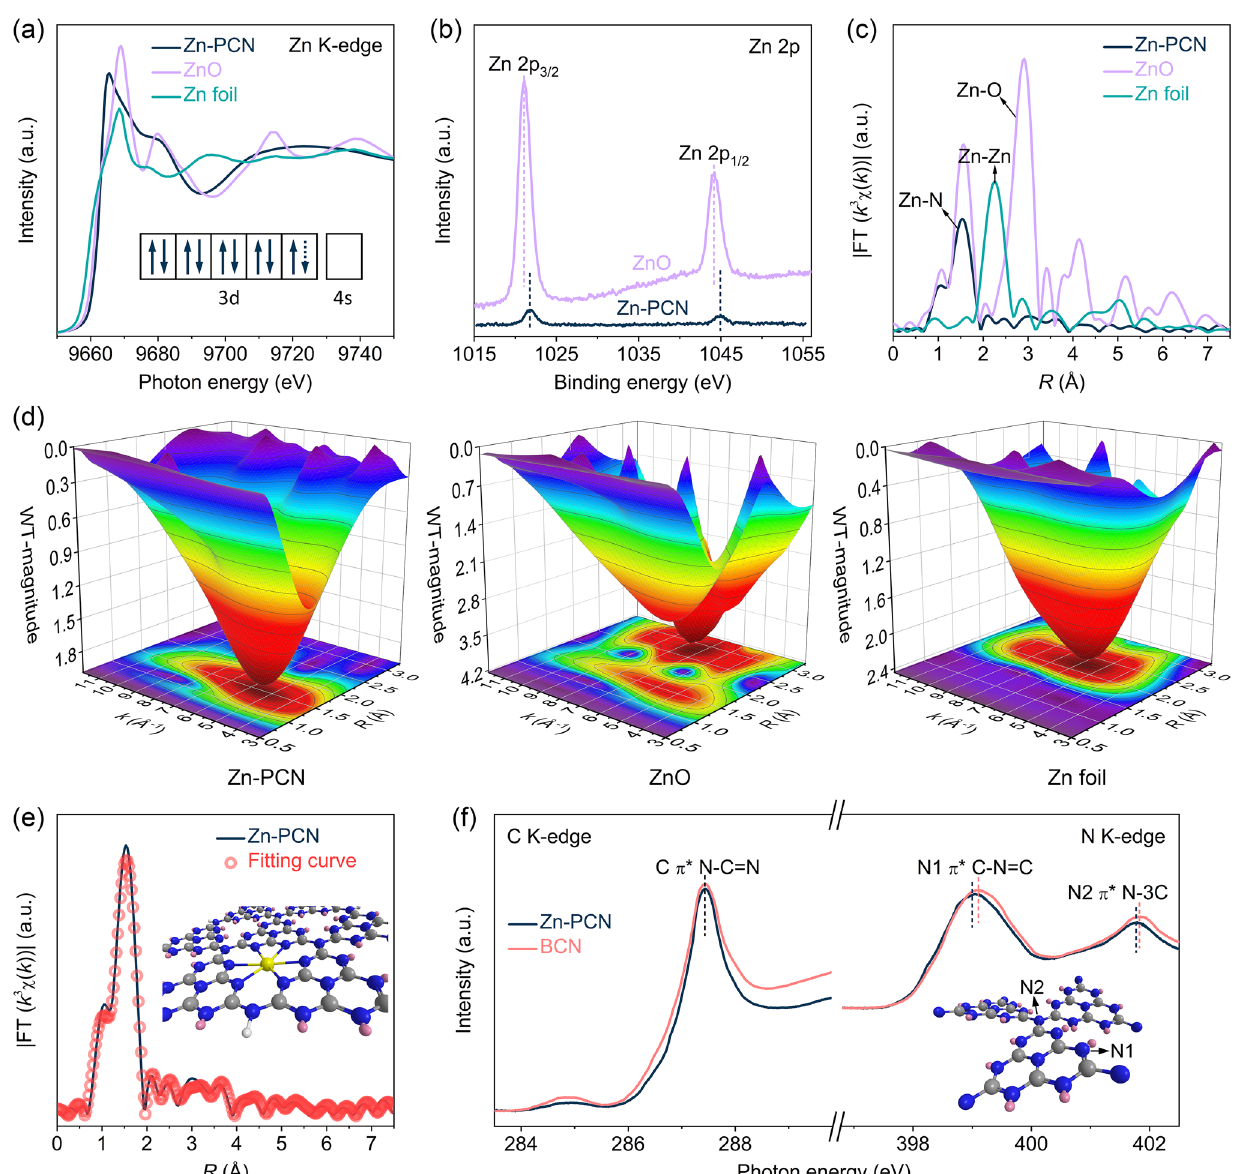
Fig. 2 a Zn K‑edge XANES spectra of Zn‑PCN, ZnO and Zn foil. The inset in a shows the outer electron configuration of Zn single atom in Zn‑PCN. b High‑resolution Zn 2 p XPS spectra of Zn‑PCN and ZnO. c Zn K‑edge k 3 ‑weighted FT‑EXAFS spectra of Zn‑PCN, ZnO and Zn foil. d WT‑EXAFS spectra of Zn‑PCN, ZnO and Zn foil. e Fitting curve of FT‑EXAFS for Zn‑PCN. The inset in e shows the structure model of Zn‑PCN with one Zn atom coordinated by six N atoms. The gray, blue, white, yellow and pink spheres represent the C, N, H, Zn atoms